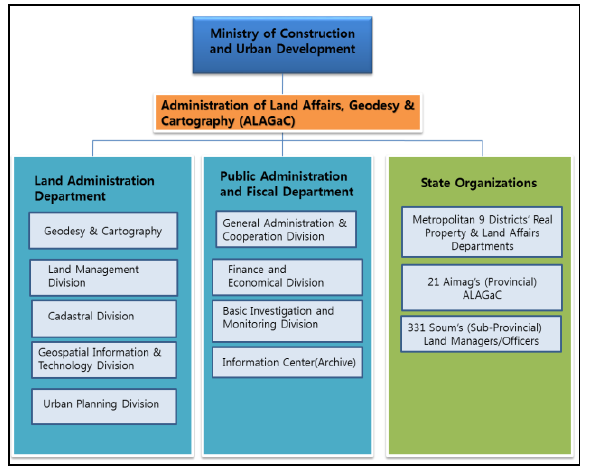
Figure 1. Organizational structure of administration of land affairs, geodesy and cartography (ALAGaC)